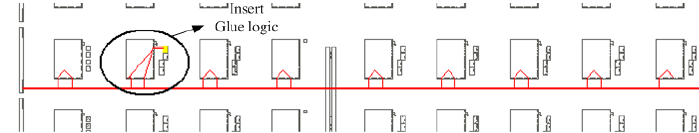
Figure 16. Insert glue logic for configurable logic block (CLB) tile.